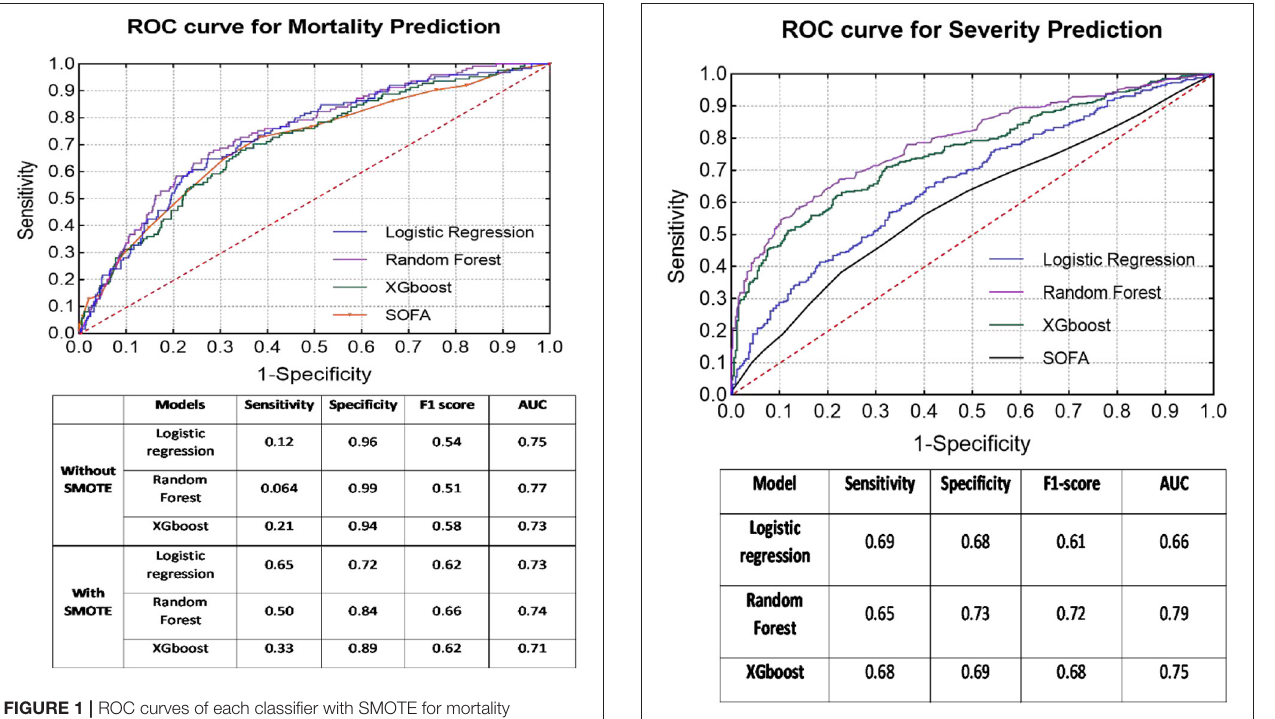
FIGURE 2 | ROC curves of each classifier for severity prediction and classification results in the table below.